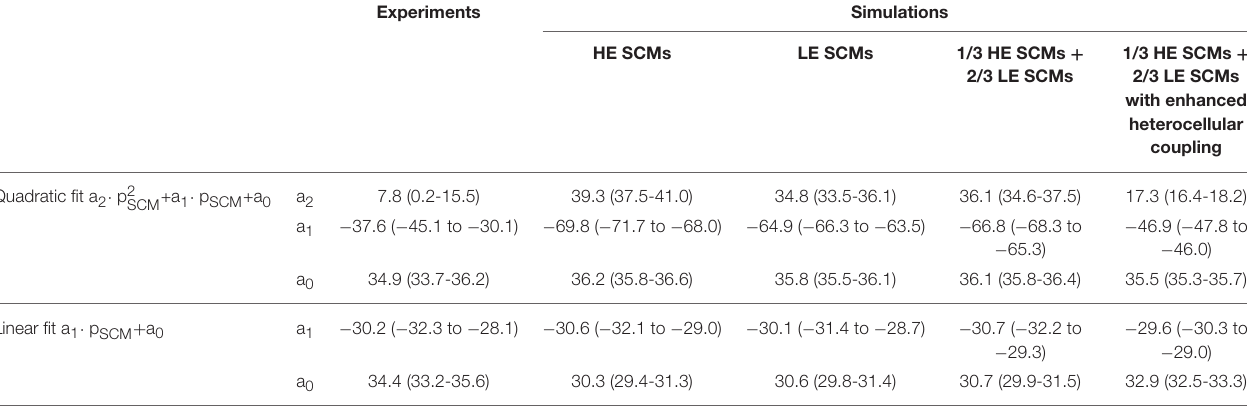
TABLE 3 | Fitting parameters for CV (in cm/s) for the simulations presented in Figure 6, in comparison to experimental data.